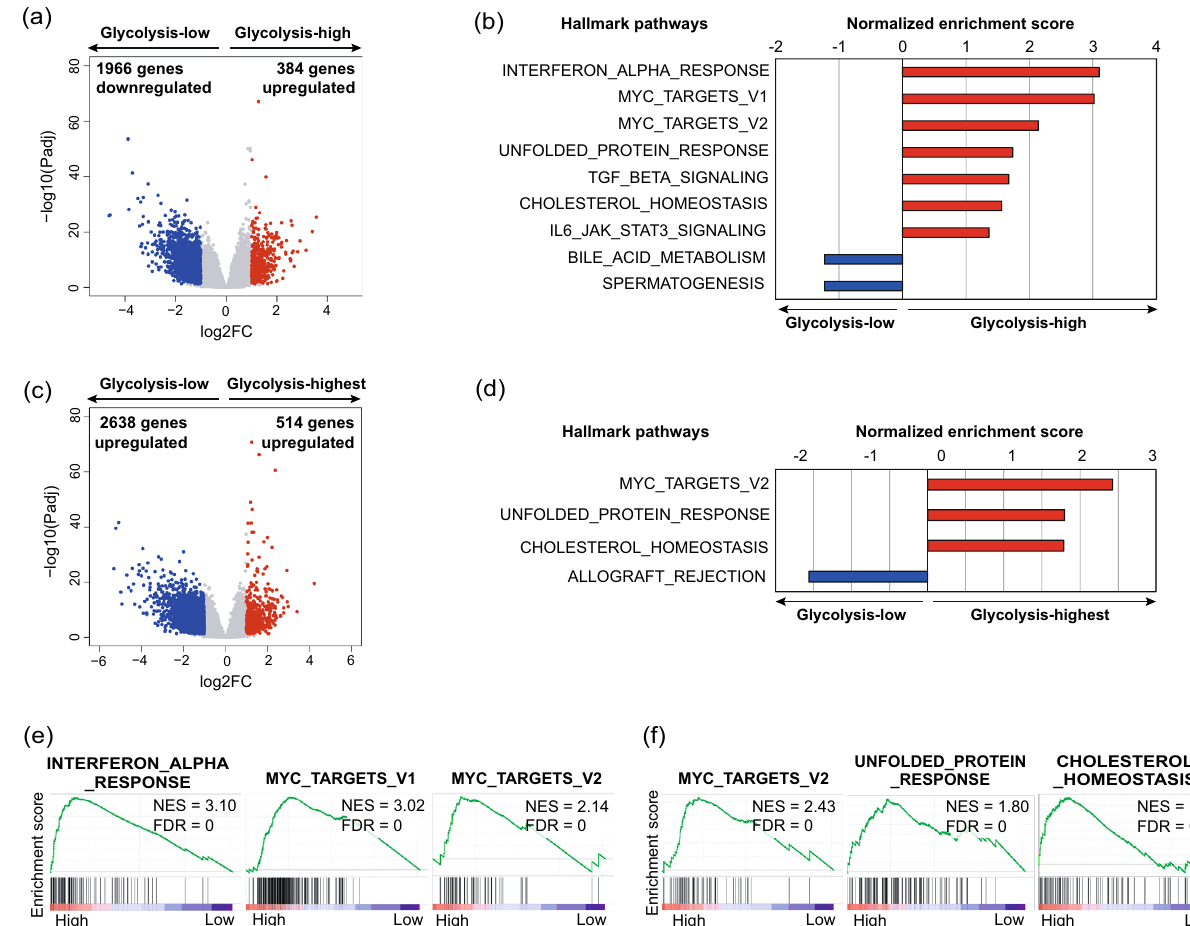
Figure 2. Several pro-tumoral pathways were upregulated in the glycolysis-upregulated groups. ( a – f ) mRNA expression data were obtained from TCGA database. ( a , c ) Volcano plot of differentially expressed genes in the glycolysis-high group or the glycolysis-highest group compared to the glycolysis-low group. Red dots represent upregulated genes (Padj < 0.05, log2FC > 1), whereas blue dots represent downregulated genes (Padj < 0.05, log2FC < -1). ( b ) Upregulated and downregulated hallmark pathways in the glycolysis-high group compared to the glycolysis-low group obtained by GSEA (FDR < 0.10). ( d ) Upregulated and downregulated hallmark pathways in the glycolysis-highest group compared to the glycolysis-low group obtained by GSEA (FDR < 0.10). ( e ) Representative GSEA plots of upregulated pathways shown in ( b ). ( f ), Representative GSEA plots of upregulated pathways shown in ( d ). TCGA, The Cancer Genome Atlas; Padj, adjusted P-value ; GSEA, gene set enrichment